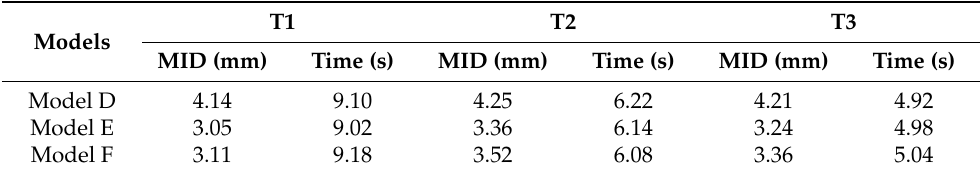
Table 13. The maximum interlayer displacement in the Y-direction.